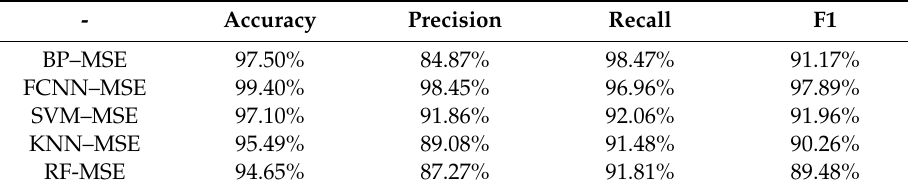
Table 6. Classification results of five algorithms combined with RFS–KNNR data